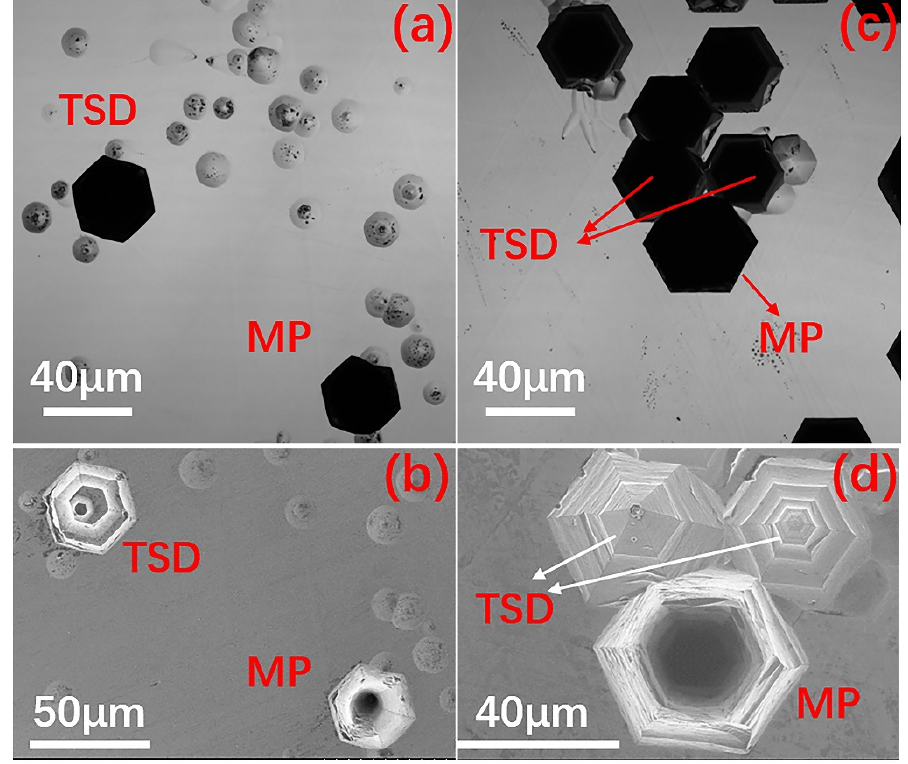
Figure 3. Etch pits of 4H-SiC ( a , b ) and 6H-SiC ( c , d ) under SEM ( b , d ) and laser confocal microscope ( a , c ).